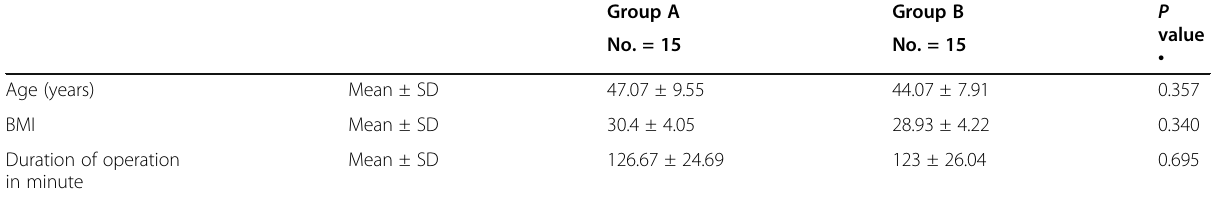
Table 1 Comparison between group A (Pecs) and group B (TPVB) regarding age, BMI, and duration of operation